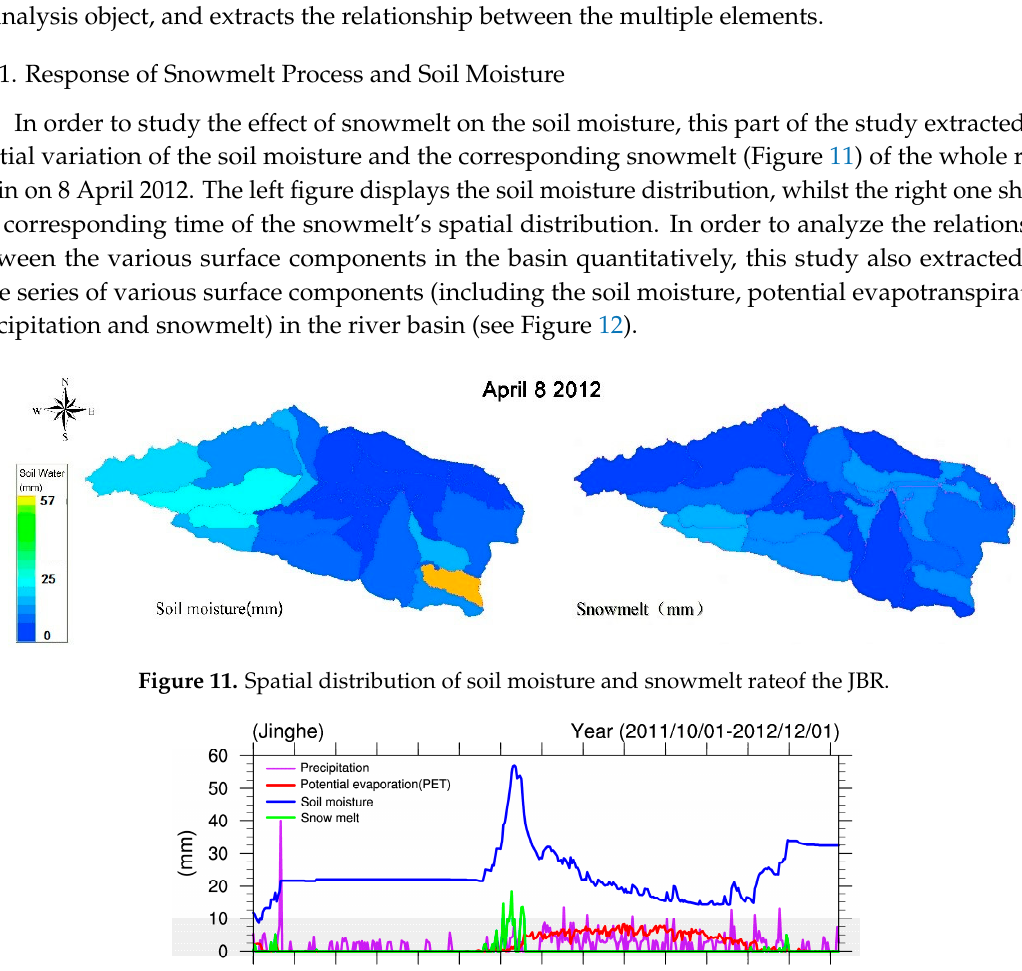
Figure 12. Time series of the parameters of the JBR (take the Jinghe mountain station as an example).